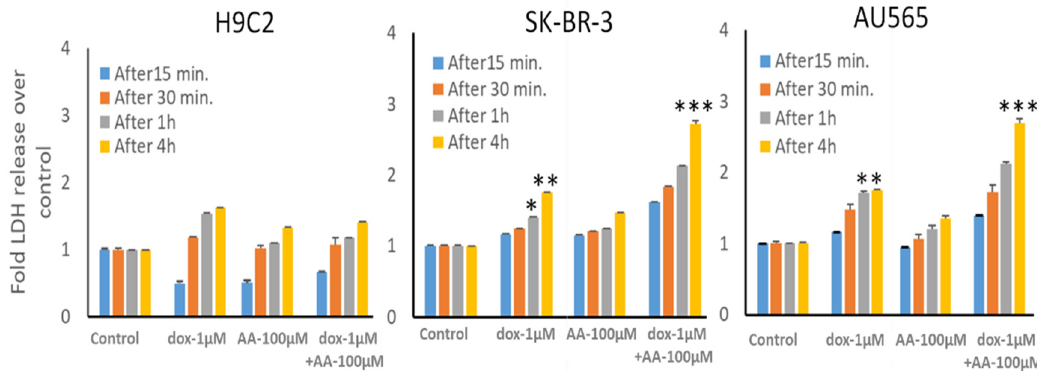
Figure 9. LDH release from H9C2 cardiomyocyte and SK-BR-3 and AU565 breast cancer cell lines by the combination of arachidonic acid and doxorubicin. LDH release by cells after treatment with 1 µ M dox and/or 100 µ M AA was performed as described in the Materials and Methods. Following treatments, media were collected from these cultures at various time points and analyzed for LDH release. The data presented show the time dependence of LDH release in all cell types compared to untreated control cells. The expressed values are means ± SD (n = 3 independent experiments with eight replicates; * p < 0.05, ** p < 0.01, *** p < 0.001).